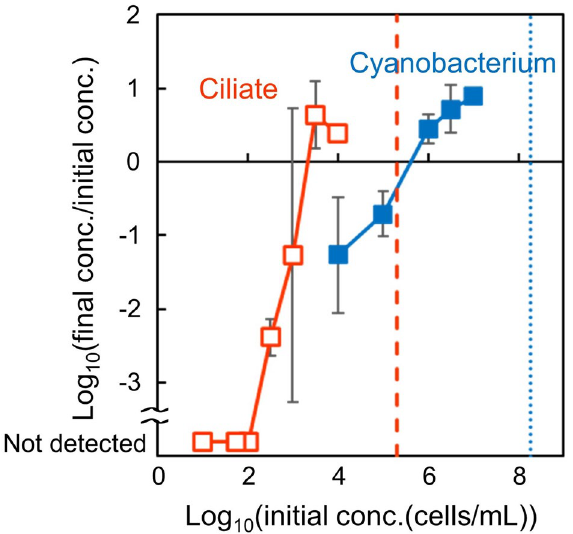
Figure 1. Growth characteristics of the cyanobacterium and ciliate cell populations in monocultures using TCM1 Glc− . Blue-closed and red-open squares show the fold-changes in the cell concentration, after 3.5 days of culture of the cyanobacterium and ciliate, respectively. Each plotted data is the mean of at least 2 independent cultures, and the error bars indicate the standard deviation. Specifically, for the initial concentrations of the ciliate, 10 1 , 10 1.75 , 10 2 , 10 2.5 , 10 3 , 10 3.5 , and 10 4 cells/mL, the number of experimental replicates were 2, 4, 2, 10, 4, 3, and 3, respectively. For the initial concentrations of the cyanobacterium, 10 4 , 10 5 , 10 6 , 10 6.5 , and 10 7 cells/mL, the number of experimental replicates were 4, 4, 4, 15, and 3, respectively. The blue-dotted and red-dashed lines are the saturation concentrations of monocultures of the cyanobacterium in TCM1 Glc− and the ciliate in TCM1, respectively, and thus having an initial concentration higher than the tested concentration is not applicable for subculture experiments like experimental